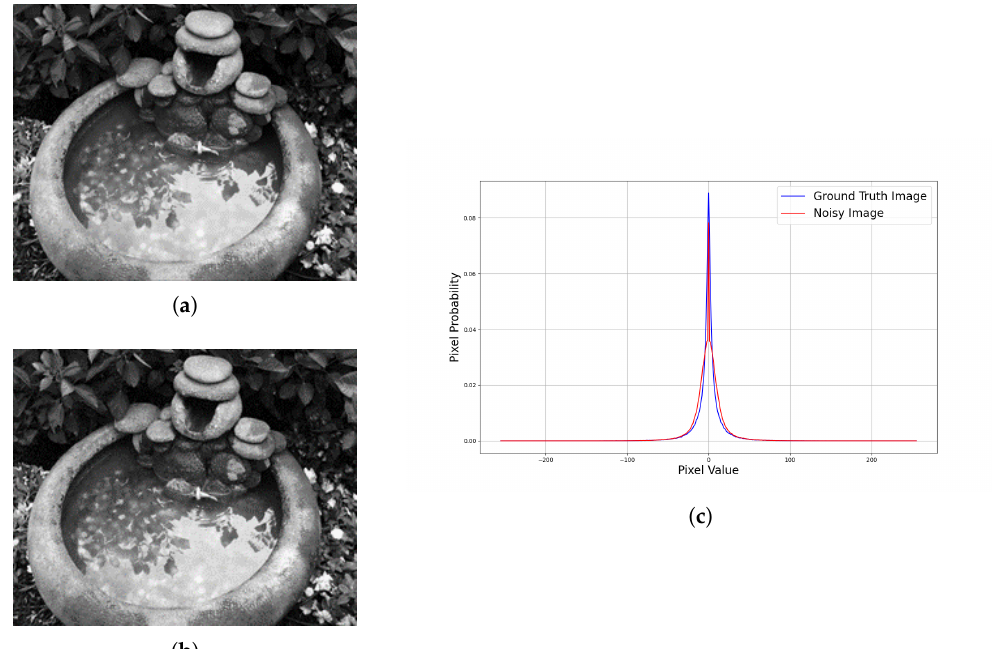
Figure 2. Ground truth–noisy image pair with their respective image gradient statistics. The image gradient statistics are very close to each other, which are similar to the original image, but the features are clearly described through the image gradient statistics. ( a ) Ground truth image. ( b ) Noisy image.